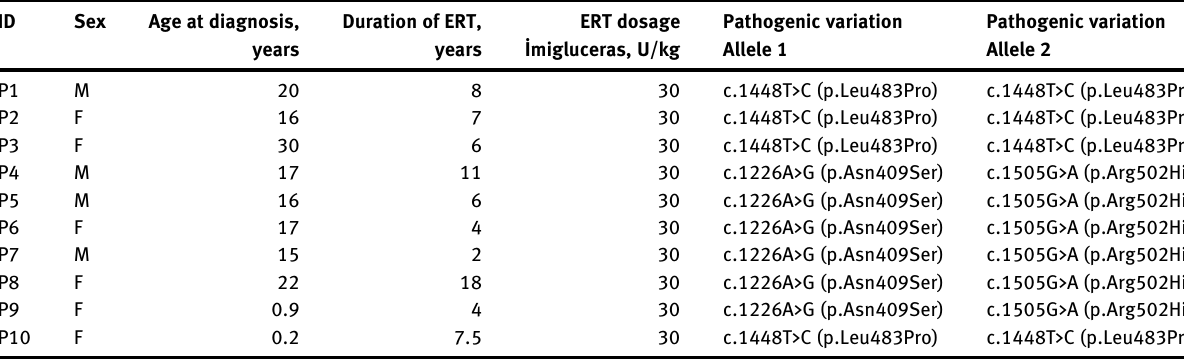
Table  : Characteristics of patients with Gaucher disease type 